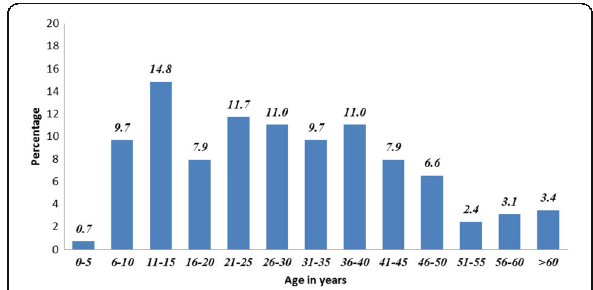
Fig. 1 Percentage of Mf survey population in each age class